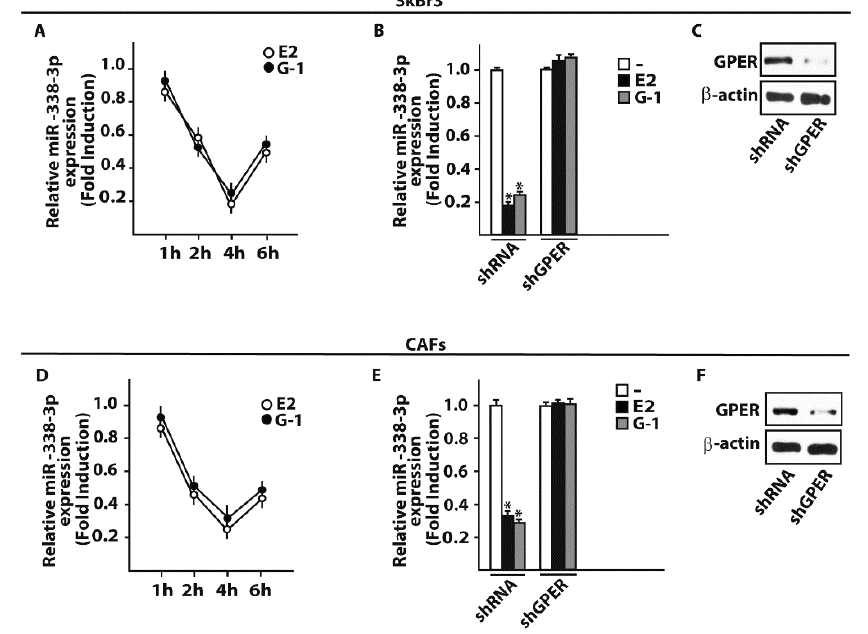
Figure 4. E2 and G-1 down-regulate miR-338-3p levels in SkBr3 cancer cells and CAFs. SkBr3 breast